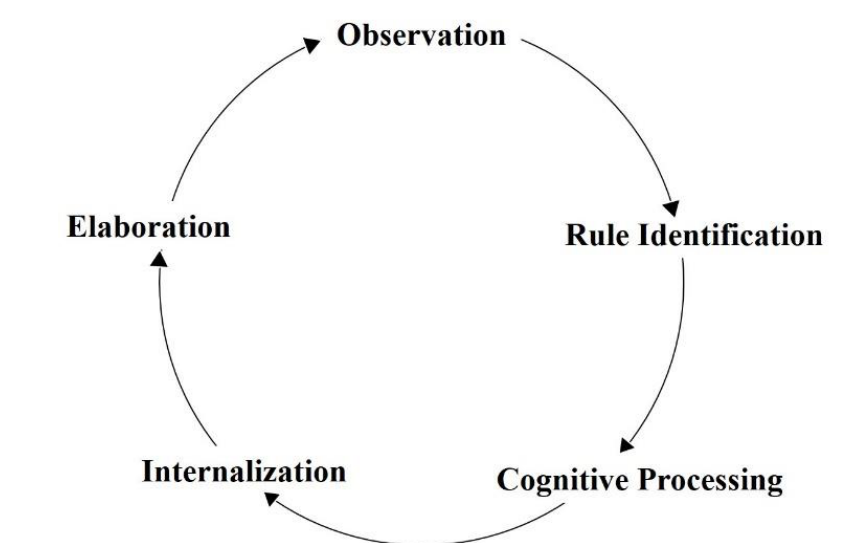
Figure 2. Learning process with examples.